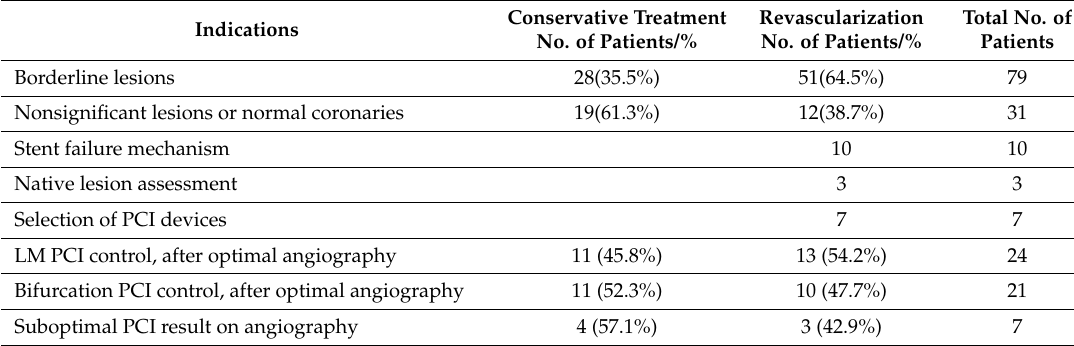
Table 4. Treatment options after